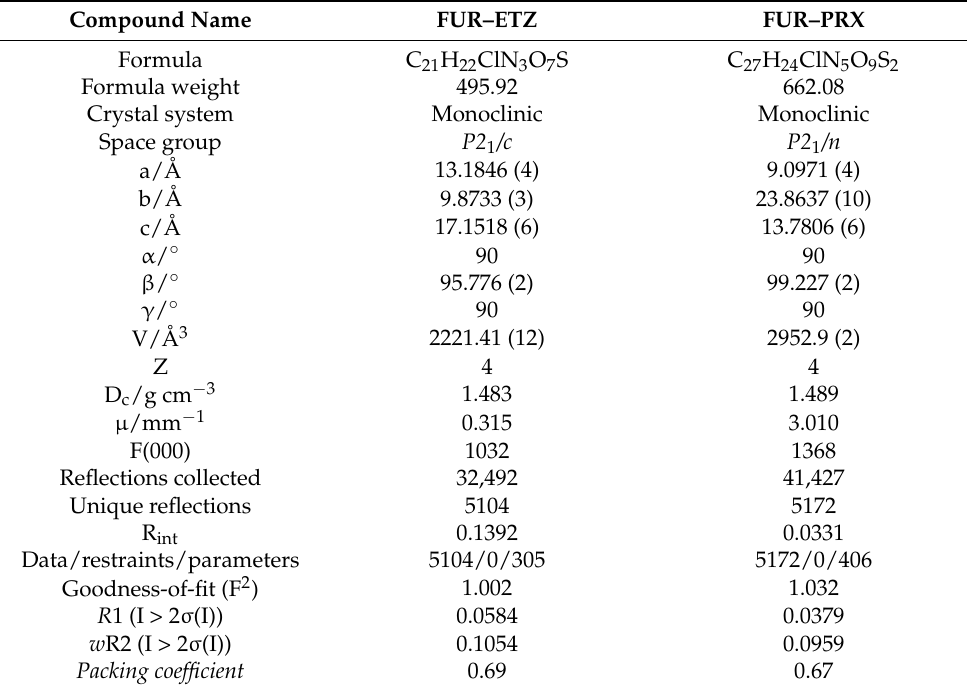
Table 1. Crystallographic data and structure refinement details of FUR